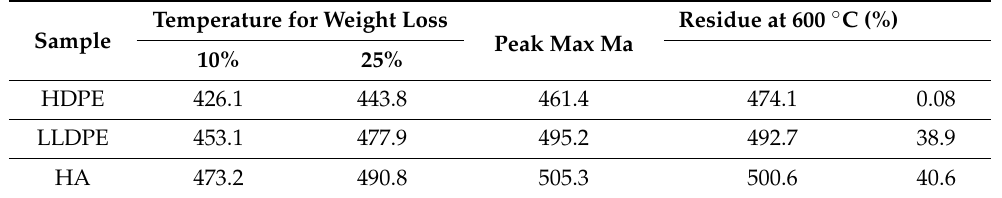
Table 5. TGA analysis of proposed